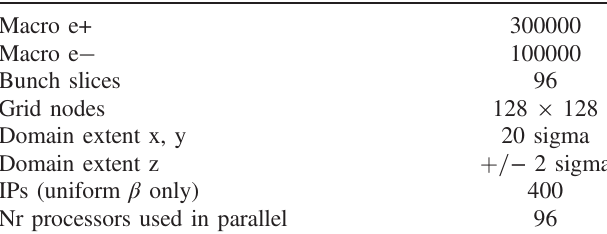
TABLE VI. List of computational parameters used in the CMAD simulations. The number of IPs is used only in the continuous-focusing